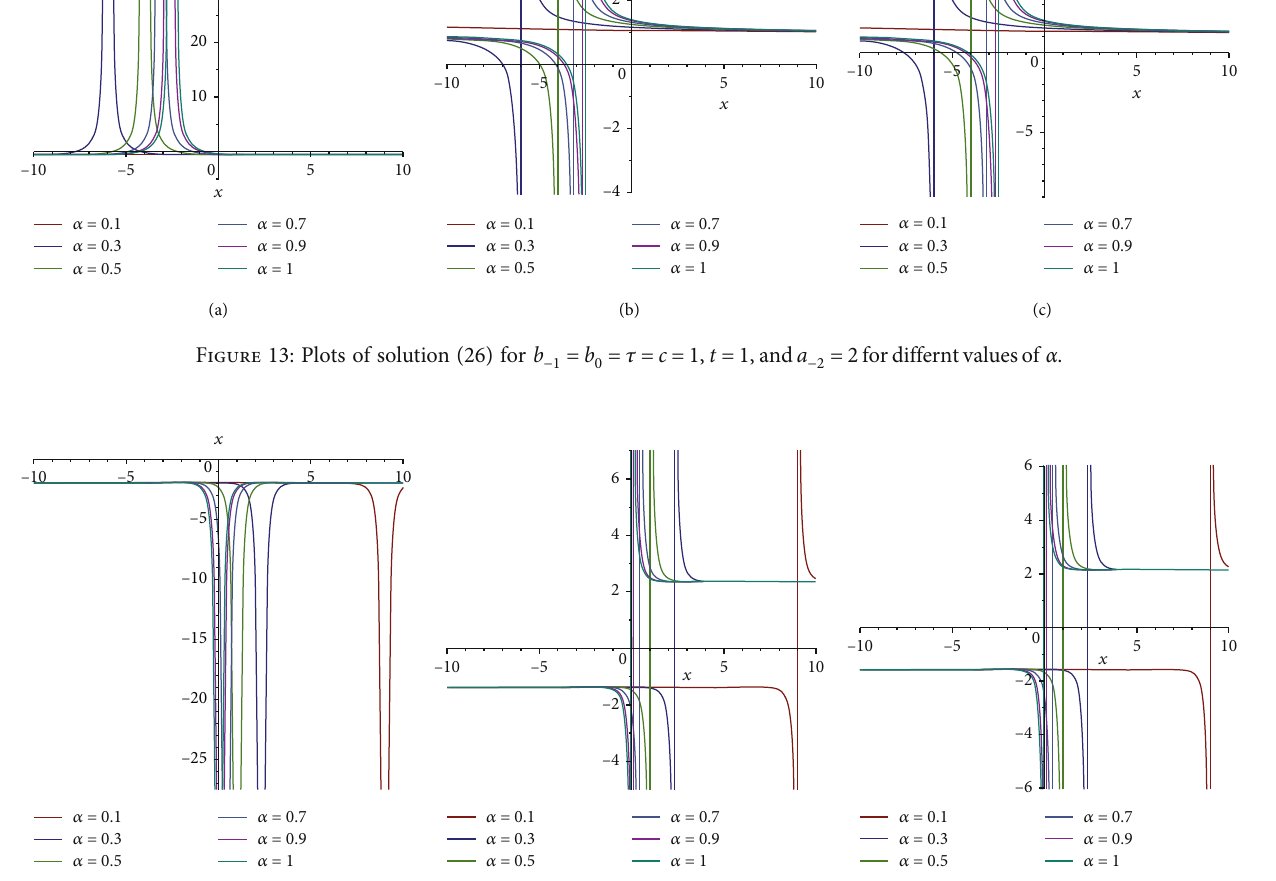
Figure 14: Plots of solution (28) for α = 0 : 5, b